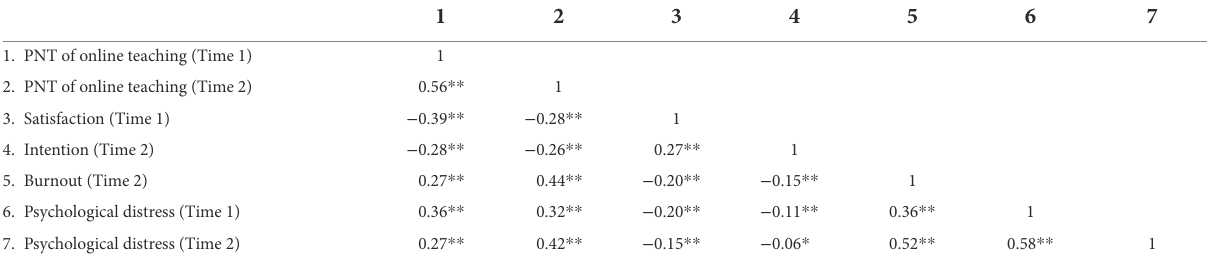
TABLE 2 Pearson correlations among the variables of psychological need thwarting (PNT) of online teaching, satisfaction, intention, burnout, and psychological distress for the longitudinal data ( n =